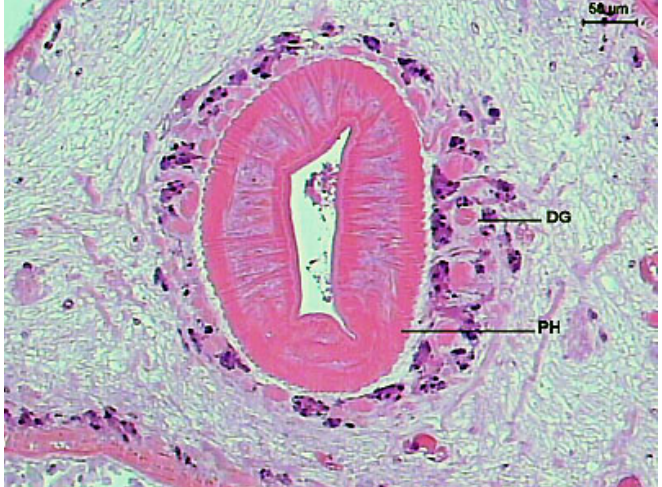
Figure 7. Transversal section of the pharynx (PH) and digestive glands (DG) of Sticholecitha serpentis.